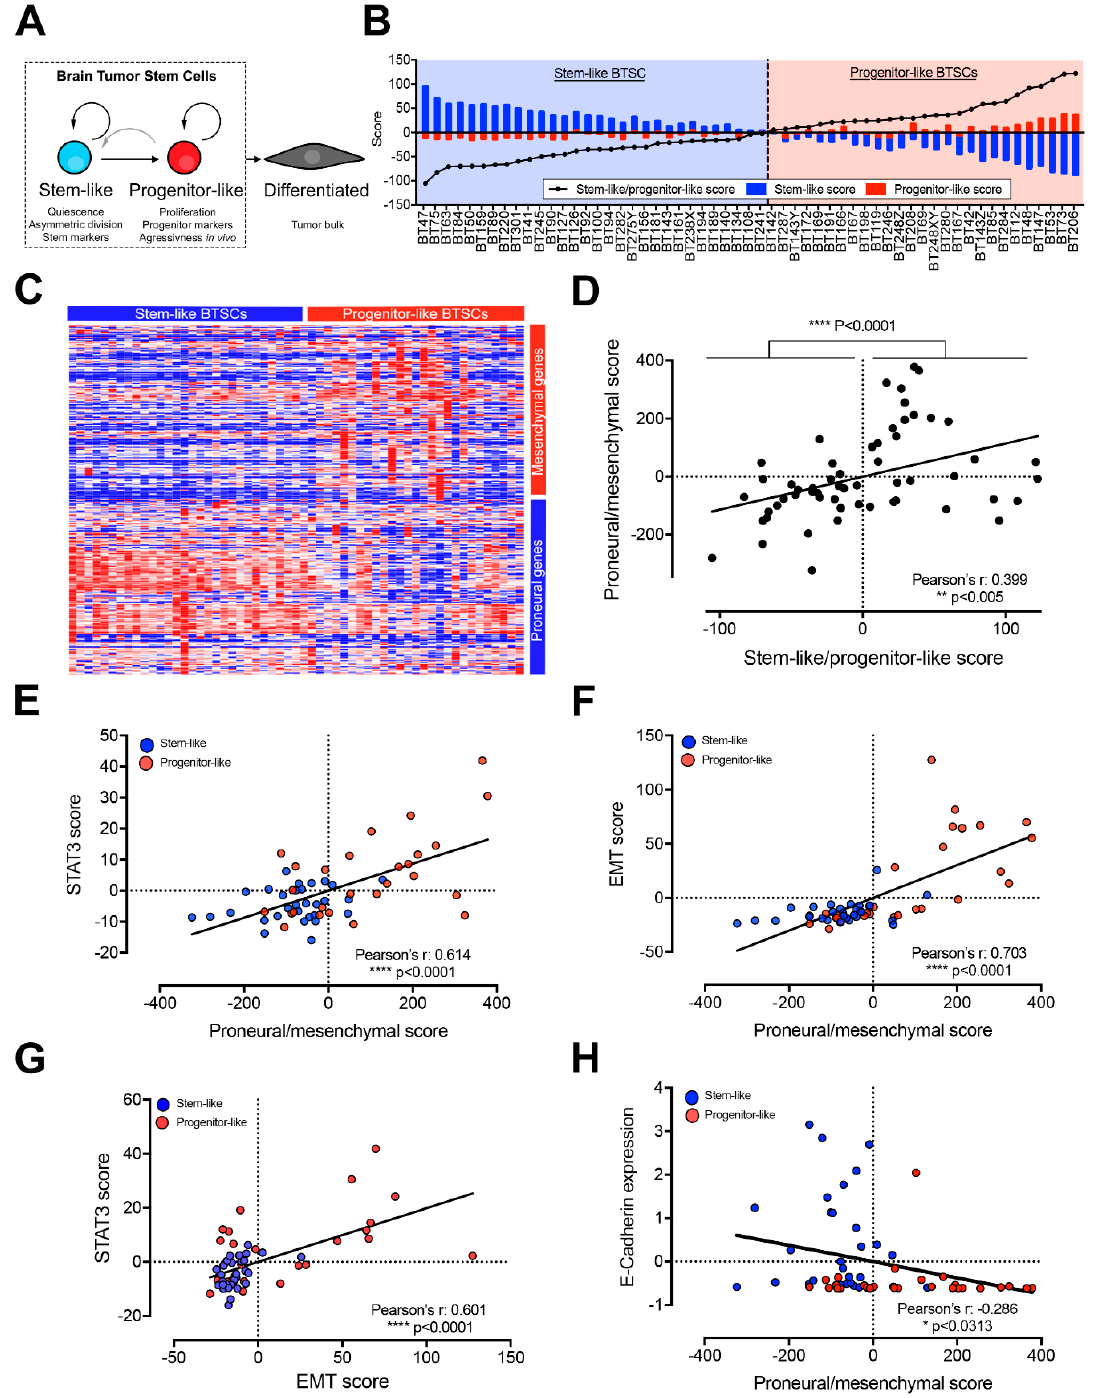
Figure 1. Stem-like and progenitor-like brain tumor stem cells (BTSCs) display proneural and mesenchymal transcriptomic profiles respectively, which correlate with epithelial to mesenchymal transition (EMT) and STAT3 pathways’ activity (see also Figures S1–S3 and Table S1). ( A ) Schematic representation of BTSC precursor states. ( B ) Bar graph showing our cohort of 57 BTSCs ranked based on the stem-like to progenitor-like score and segregated as stem-like (30 BTSCs) or progenitor-like (27 BTSCs). ( C ) Heatmap representing the expression of proneural and mesenchymal genes (from [2] and listed in Table S1) in stem-like and progenitor-like BTSCs in the same order than Figure 1B (expression data can be found on the EGA platform). ( D ) Scatter plot showing the correlation between the proneural to mesenchymal and the stem-like to progenitor-like scores in BTSCS. Scatter plots showing the correlation between the proneural to mesenchymal score and ( E ) STAT3 or ( F ) EMT scores in